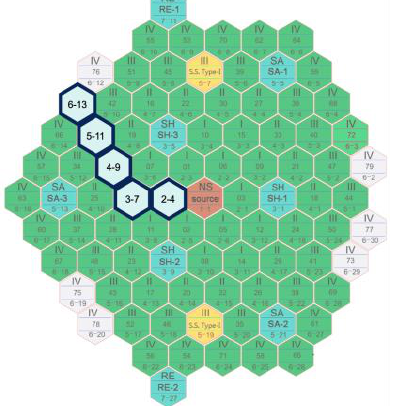
Figure 7. Positions and SA Loading for Swap Reactivity Measurement. (Red: fuel SAs, Purple: Type-I SS